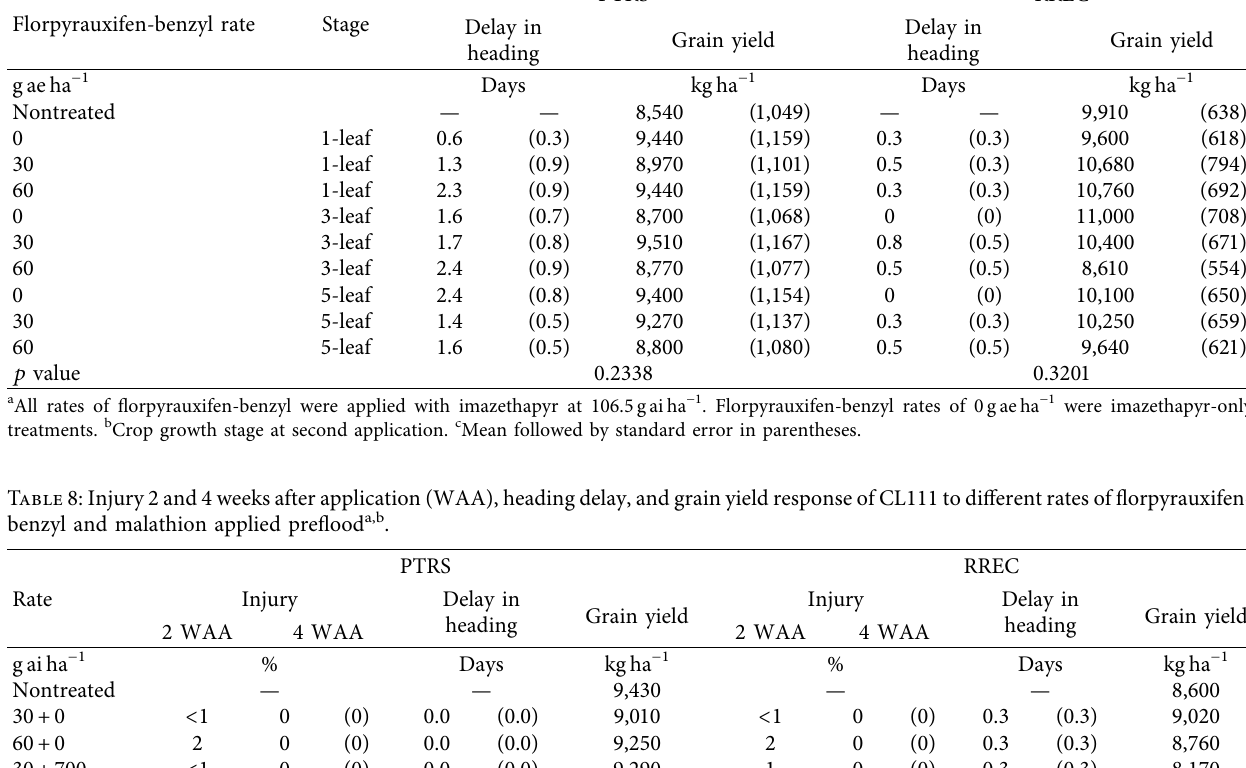
PTRS RREC Stage Delay in Delay in Grain yield Grain yield heading heading